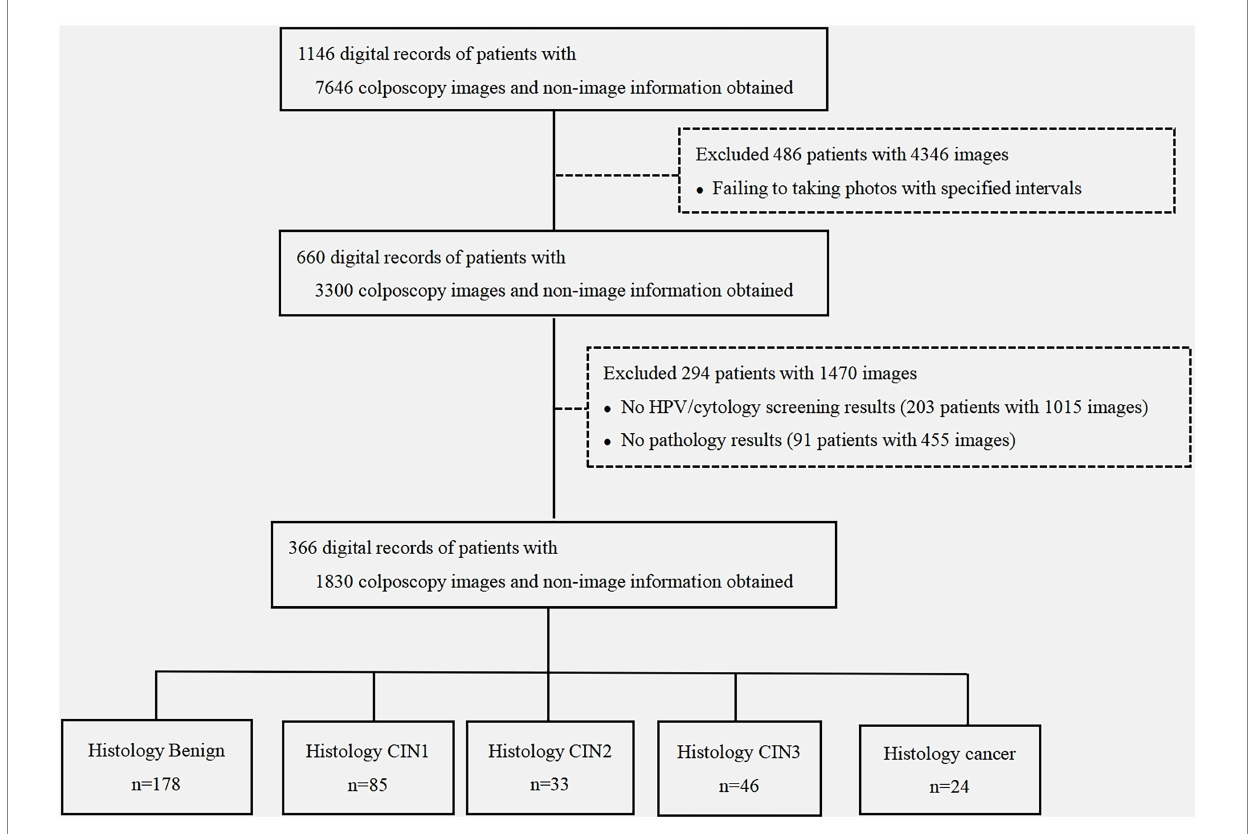
FIGURE 1 Study flowchart. Non-imaging information comprised the clinical characteristics [human papillomavirus (HPV) status, cytological findings, colposcopic impression, and biopsy results] and demographic characteristics (age, educational level, reproductive history, and menopausal stage) obtained from the medical records. CIN, cervical intraepithelial neoplasia; HPV, human papillomavirus; CIN1, CIN grade 1; CIN2, CIN grade 2; CIN3, CIN grade